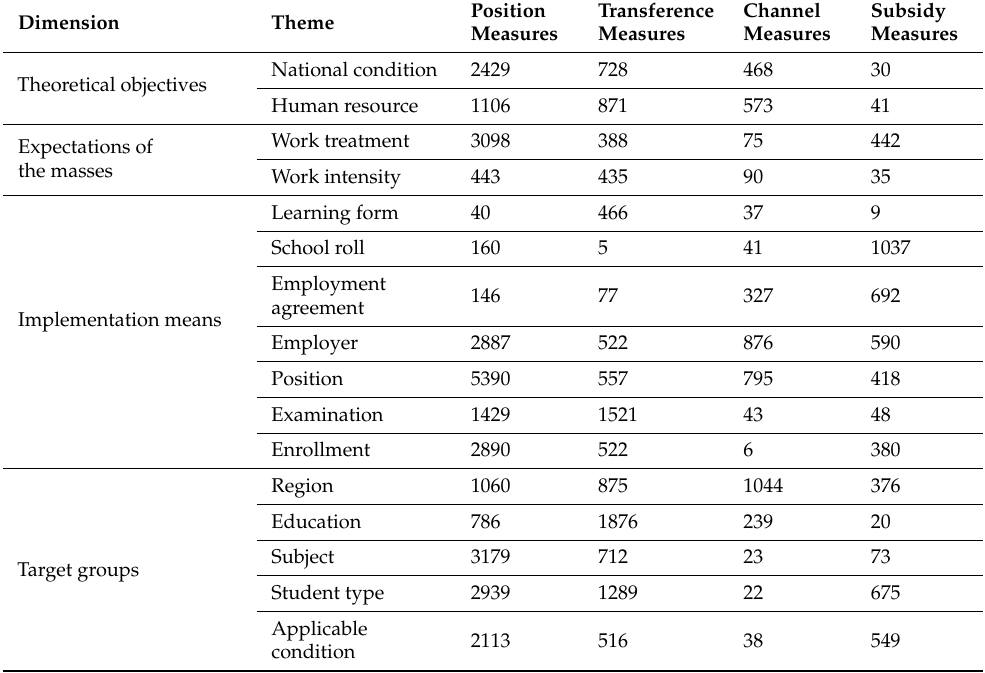
Table 9. Classification of